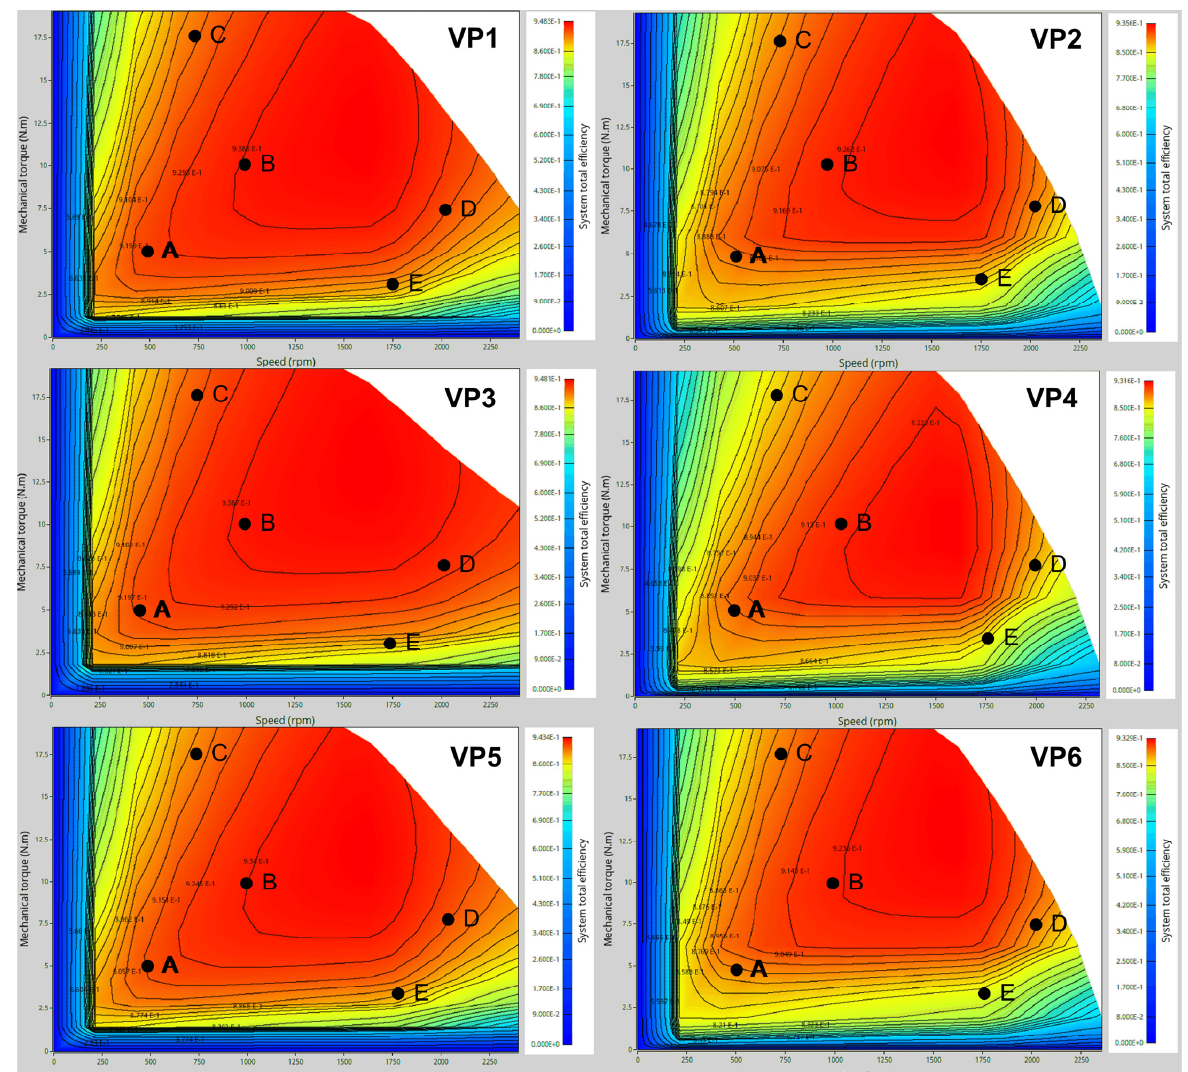
Figure 5. Torque–speed–efficiency maps of the considered virtual prototypes . Table 8. Efficiency maps’ comparison .